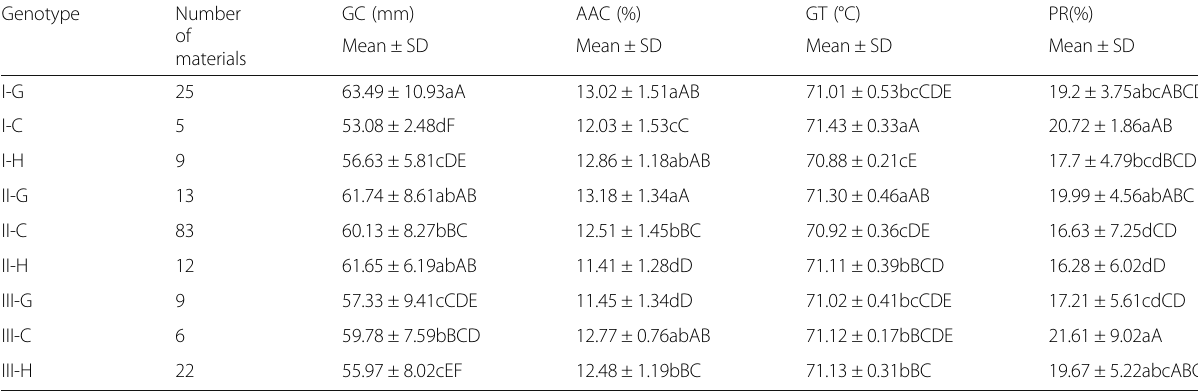
Table 2 Comparison of physicochemical indexes among different combinations of AGPlar and SSIV-2 alleles